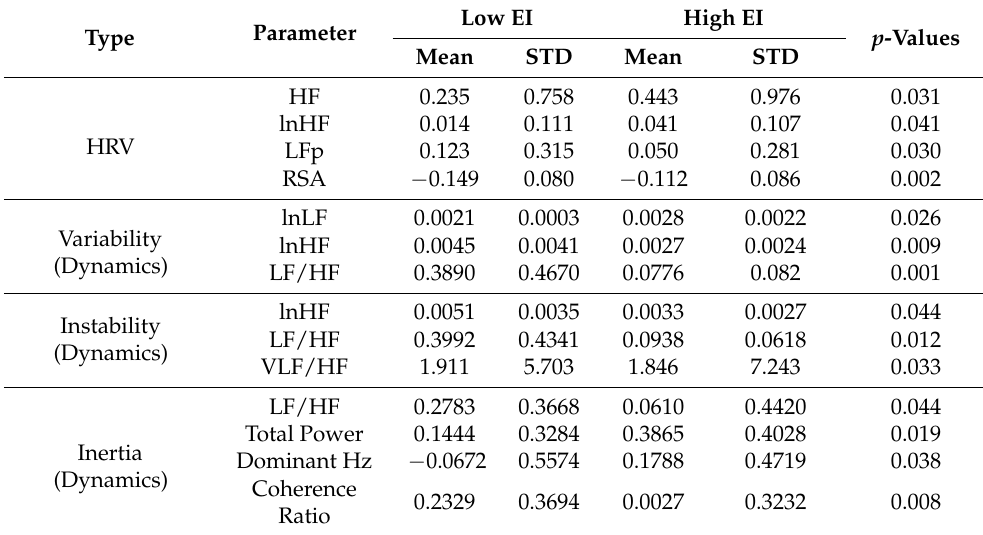
Table 8. The statistical comparison of HRV and dynamics between the two EI levels. Low Type Parameter